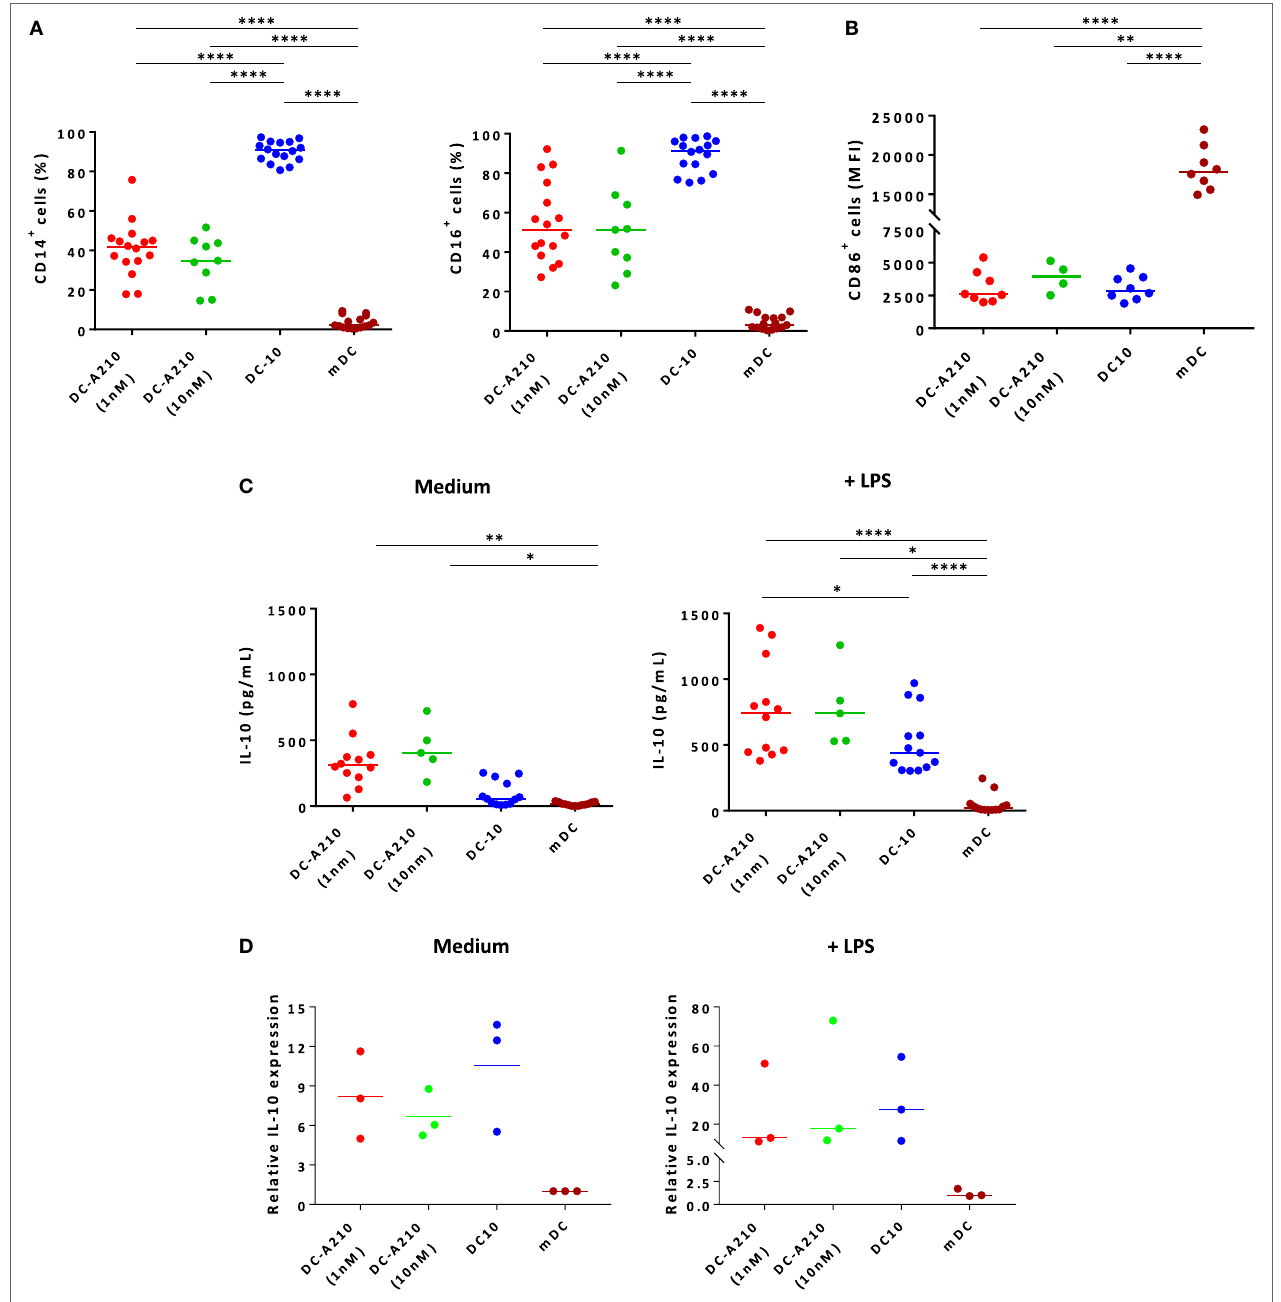
FigUre 1 | Tolerogenic DC can be differentiated from CD14 + monocytes in the presence of APVO210. DC were differentiated from CD14 + monocytes in the presence of IL-4 + GM-CSF [mature DC (mDC)], and of exogenous rhIL-10 [dendritic cells (DC-10)], or of APVO210 used at two different concentrations (DC-A210, 1 or 10 nM). (a) Percentage of CD14 + and CD16 + was assessed by flow cytometry in DC-A210 (1 nM: n = 16; 10 nM: n = 9), DC-10 ( n = 16) and mDC ( n = 16). (B) Median fluorescence intensity of CD86 is shown in CD86 + in DC-A210 (1 nM: n = 7; 10 nM: n = 3), DC-10 ( n = 8) and mDC ( n = 8). (c) Production of IL-10 was evaluated by ELISA in culture supernatants of DC-A210 (1 nM, n = 12; 10 nM, n = 5), DC-10 ( n = 13), and mDC ( n = 13) after 48 h, in the presence or absence of LPS stimulation. (D) IL-10 mRNA expression levels were evaluated in DC-A210, DC-10, and mDC ( n = 3) by quantitative RT-PCR after 24 h in the presence or absence of LPS stimulation. Data are represented in fold-change of expression compared to mDC. Median values are indicated and each dot represents a single donor. Paired t -tests with Bonferroni correction were performed for statistical analysis. * p < 0.05, ** p < 0.005, **** p <